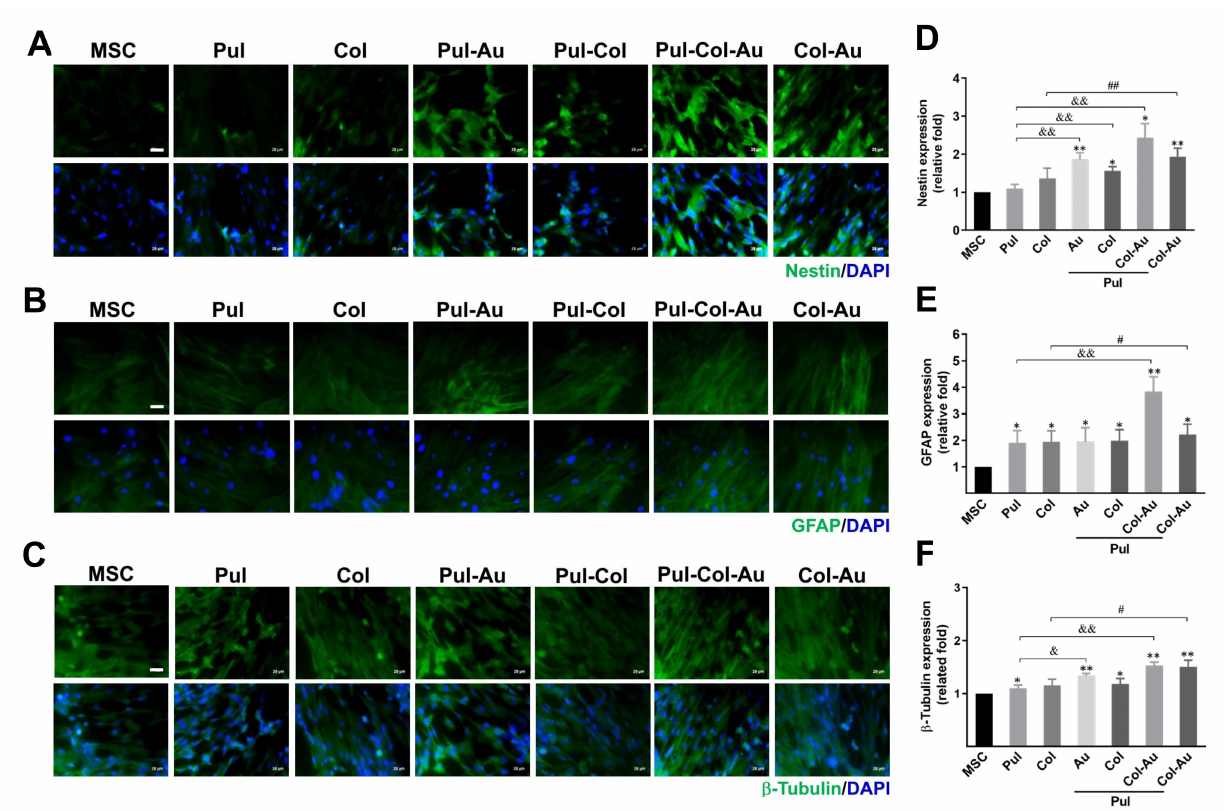
Figure 7. Identification of neuronal differentiation for MSCs influenced by various nanomaterials. The cells, after culturing with the nanomaterials for 7 days, were detected by immunostaining with neuronal markers ( A , D ) nestin, ( B , E ) GFAP, and ( C , F ) β -tubulin antibodies. The protein expression level was semi-quantified based on the fluorescent intensity, with the results indicating that the greatest expression for each marker was in the Pul–Col–Au group (nestin: ~2.43-fold, GFAP: ~3.83-fold, β -tubulin: ~1.52-fold). Scale bar = 20 µ m. Data are represented as mean ± SD of the three independent experiments. * p < 0.05, ** p < 0.01: compared to MSC alone group. & p < 0.05, && p < 0.01: compared to Pul group. # p < 0.05, ## p < 0.01: compared to Col